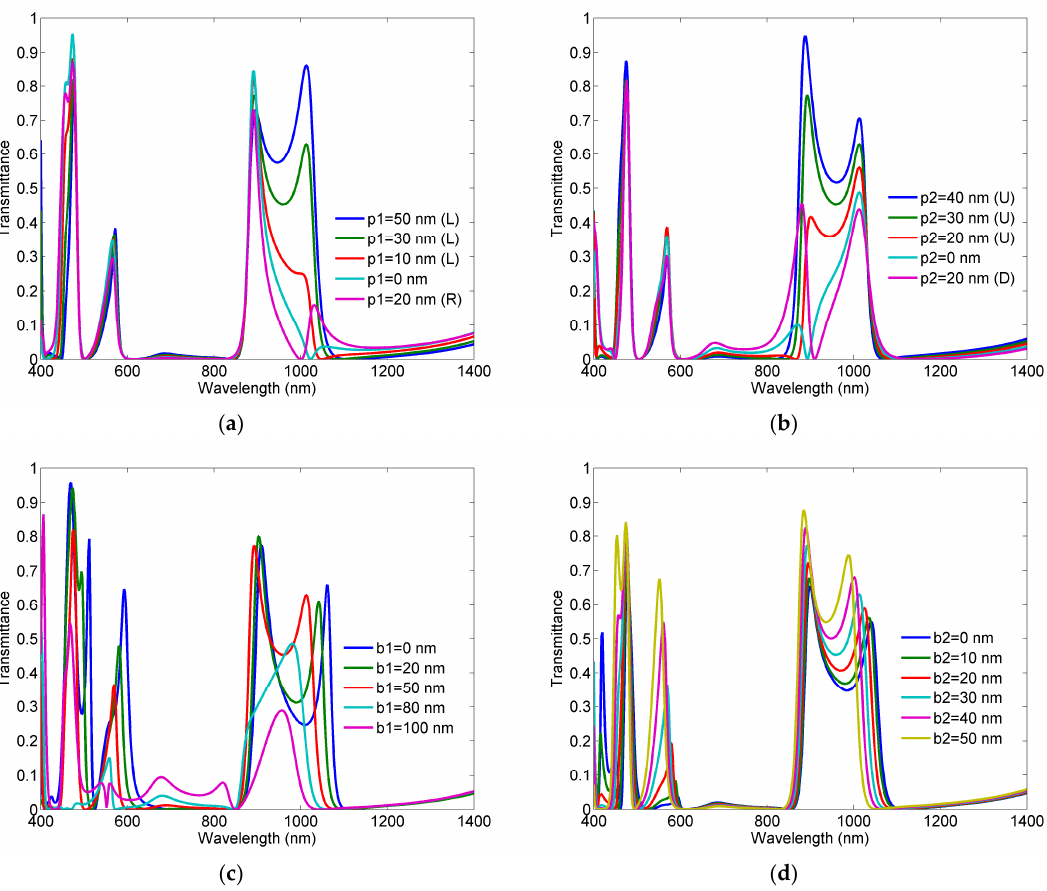
Figure 5. Response of the proposed sensor for different values of the parameter: ( a ) p 1 , L / R denotes left/right position from the symmetry axis; ( b ) p 2 U / D denotes upper/down position from the half-height point; ( c ) b 1 ; ( d ) b 2 .